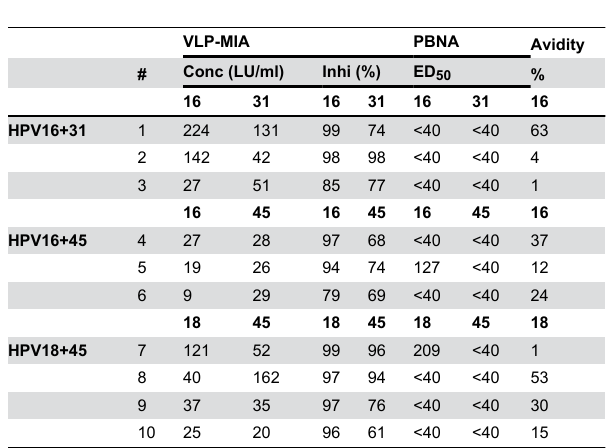
Table 4. HPV16 and HPV18 IgG subclasses (IgG1, IgG2, IgG3 and IgG4) induced by HPV infection (HPV16